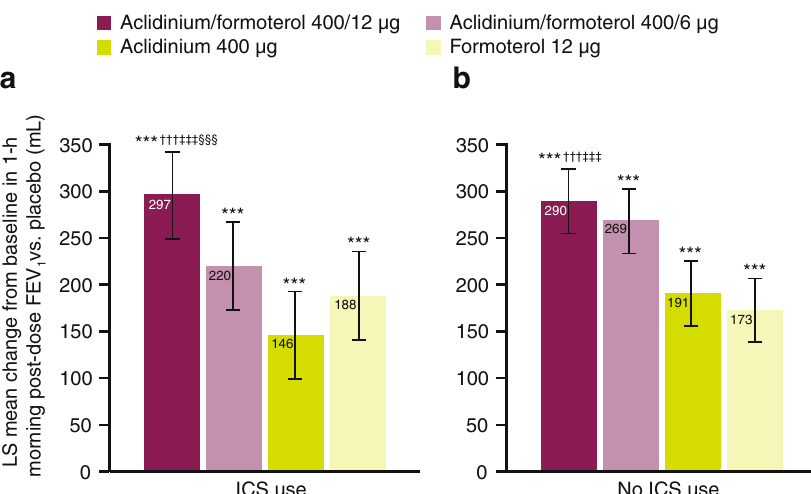
Fig. 1 LS mean change from baseline in 1-h morning post-dose FEV 1 vs. placebo at week 24 in ICS users a and non-ICS users b (pooled ITT population). *** P < 0.001 vs. placebo; ††† P < 0.001 vs. aclidinium 400 μ g; ‡‡‡ P < 0.001 vs. formoterol 12 μ g; §§§ P < 0.001 vs. aclidinium/ formoterol 400/6 μ g. Analyses based on the mixed model for repeated measures: treatment effects and treatment comparisons. Error bars represent 95% con fi dence intervals. Patient numbers for the placebo groups were: for patients using ICS, n = 137, for patients not using ICS,